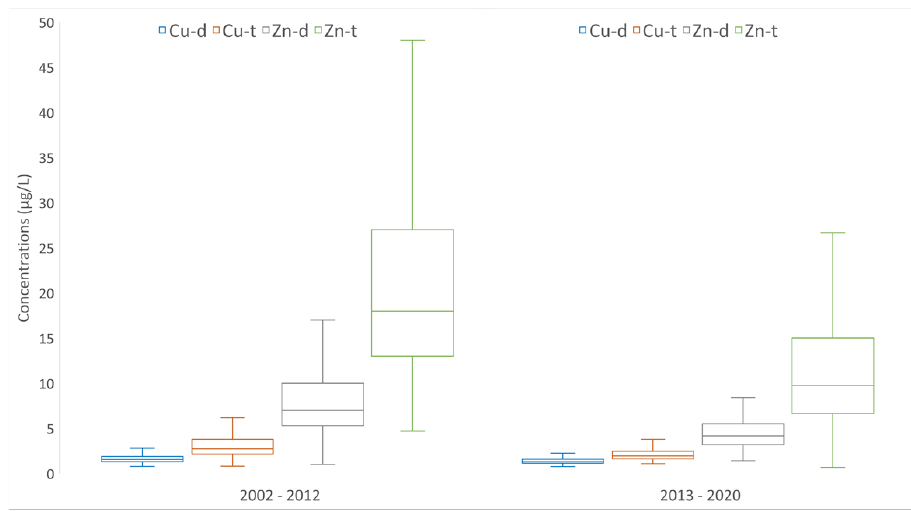
Figure 3. Copper and zinc dissolved and total concentrations at Eijsden station (Meuse) over the period 2002 – 2012 (left part of the figure) and over the period 2013 – 2020 (right part of the figure). On the French Mosel watershed, the water quality is monitored by the Rhine – Meuse Water Agency and the measurements are freely downloadable on the website of the Agency [29]. The dissolved and total copper and zinc concentrations are available for the years 2012 – 2019 from about 20 stations of the monitoring network. Adsorbed copper and zinc mass concentrations on bed sediment (particles < 2 mm) and on suspended sediments (particles < 2 mm) are available for the years 2012 – 2017 (no data were available between 2017 and 2019) from six stations of the monitoring network.